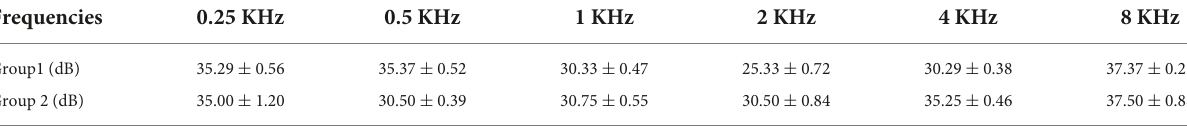
TABLE 2 The average preoperative BC in patients with type I labyrinthine fistulas in group 1 and 2. Frequencies